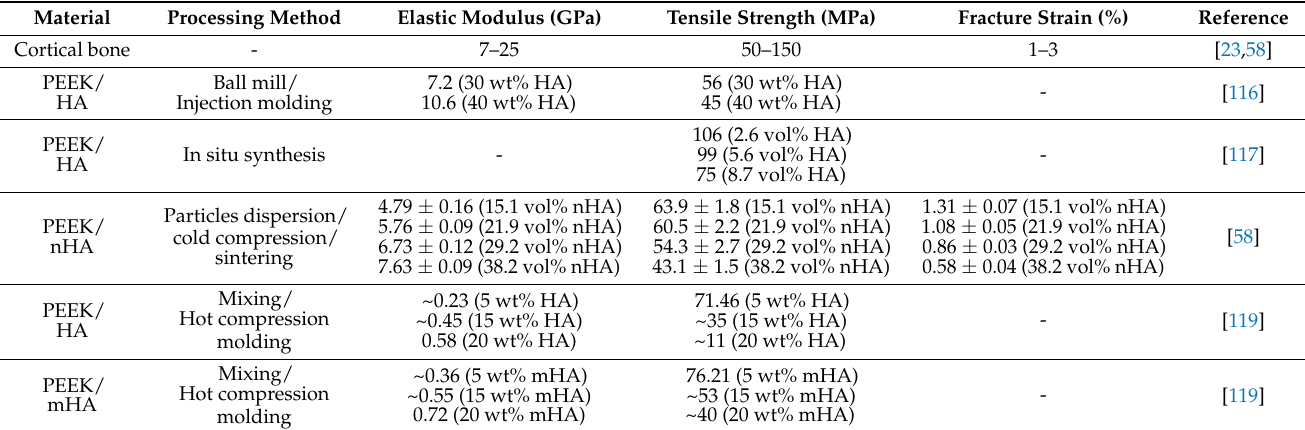
Table 4. Mechanical properties of PEEK composites and cortical